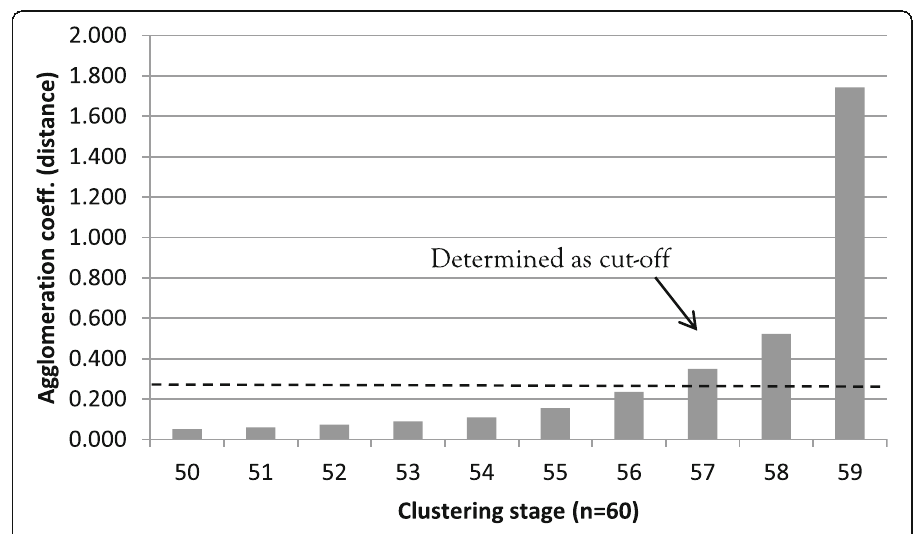
Fig. 7 Final 10 stages of the hierarchical clustering